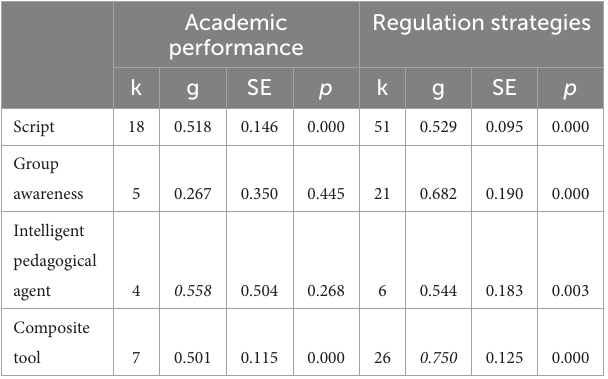
TABLE 7 Scaffolding’ effects by learning